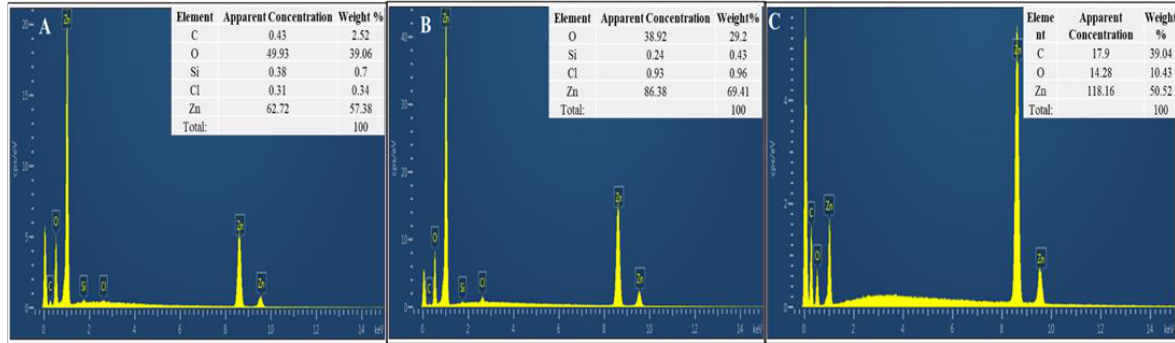
11 of 22 Figure 3. SEM images of ZnONPs. ( A , B ) CE-ZnONPs at ×50 magnification (500 µm) and ×200 (100 µm) ( C , D ) CE-UV-A- ZnONPs at ×2000 magnification (10 µm) and ×5000 (5 µm) ( E , F ) CE-UV-C-ZnONPs at ×2000 magnification (10 µm) and ×5000 (5 µm).